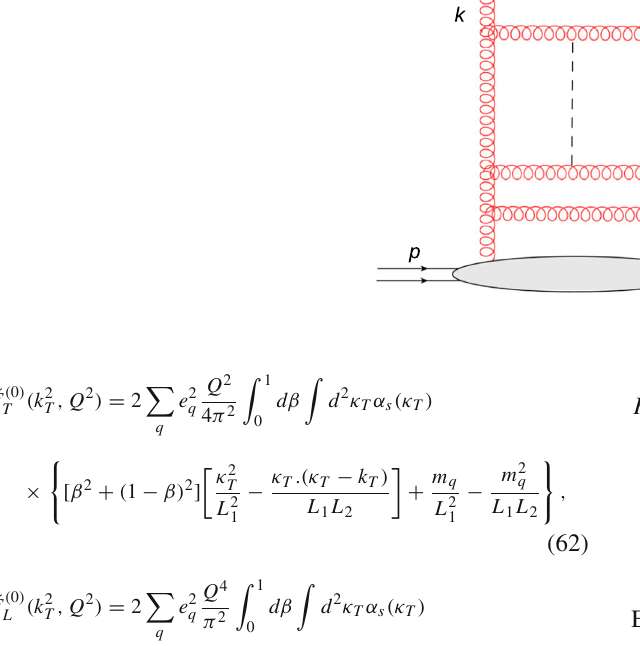
Fig. 13 Diagrammatic representation of the factorization formula (59) where gluon couples to virtual photon through the a quark box (left) and b crossed box (right)